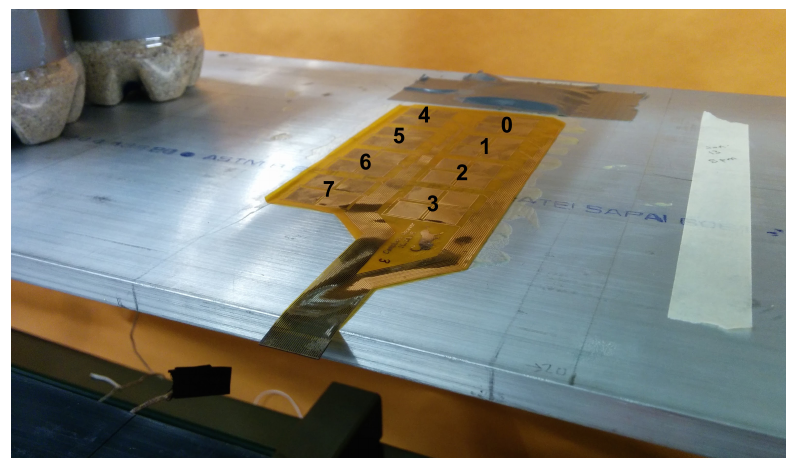
Figure 14. Sensing sheet, and individual sensor numbering convention.